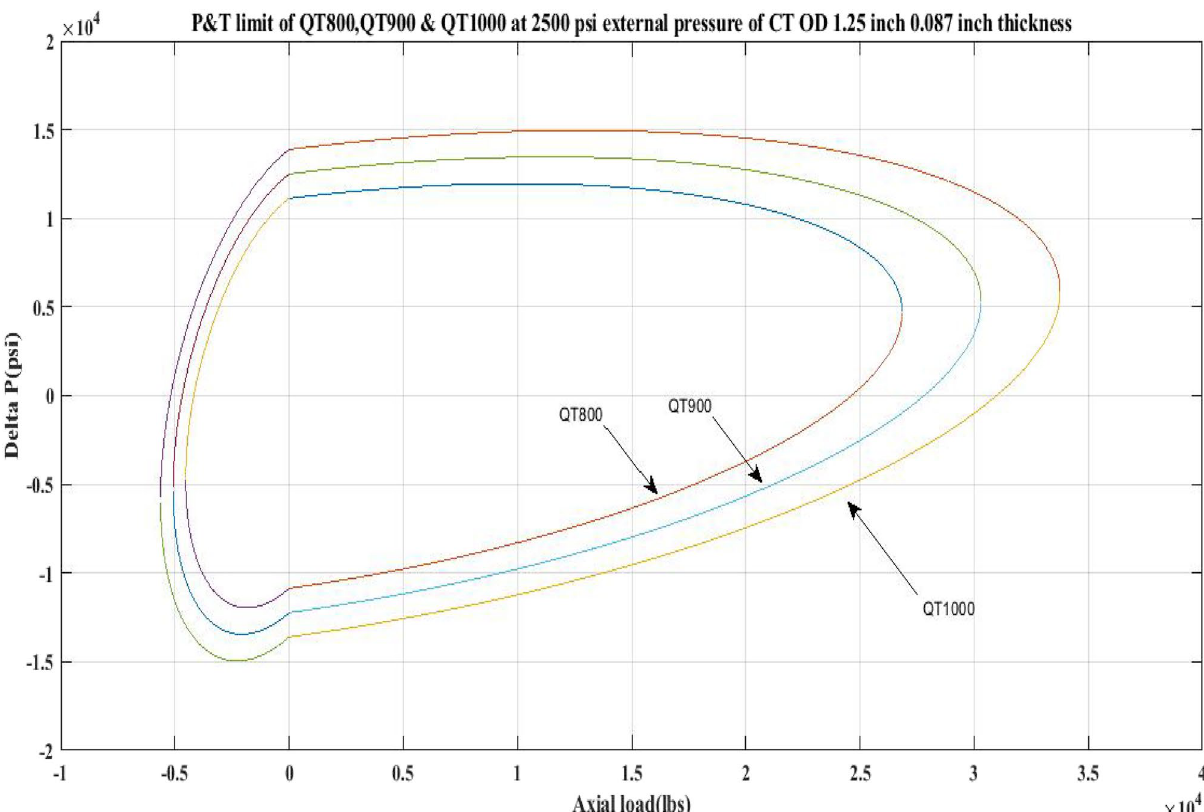
Figure 5. Pressure and tension limits for QT 800, QT900 and QT 1000 at 2500 psi external